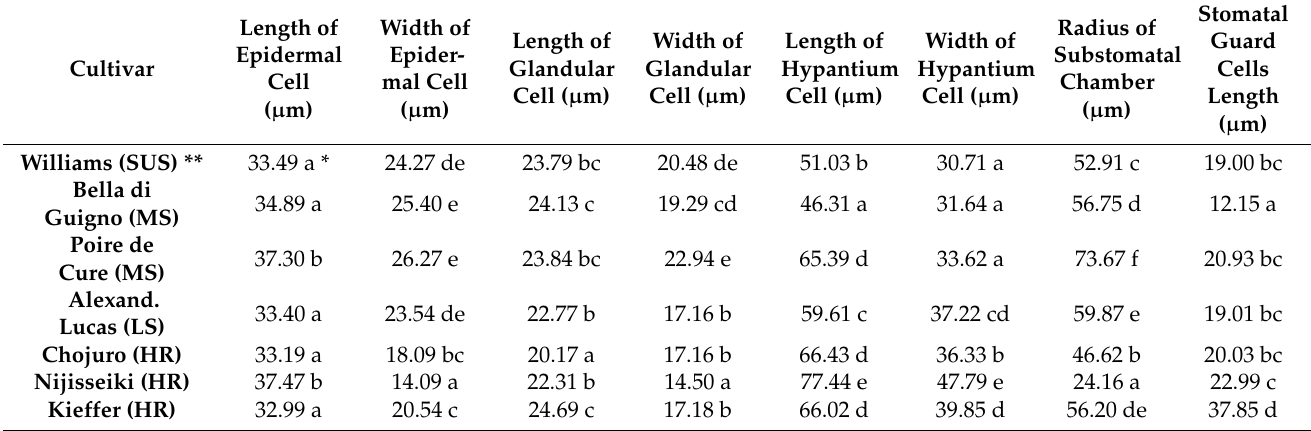
Table 1. Measurements of epidermal, secretory, hypanthial and stomatal cell size ( µ